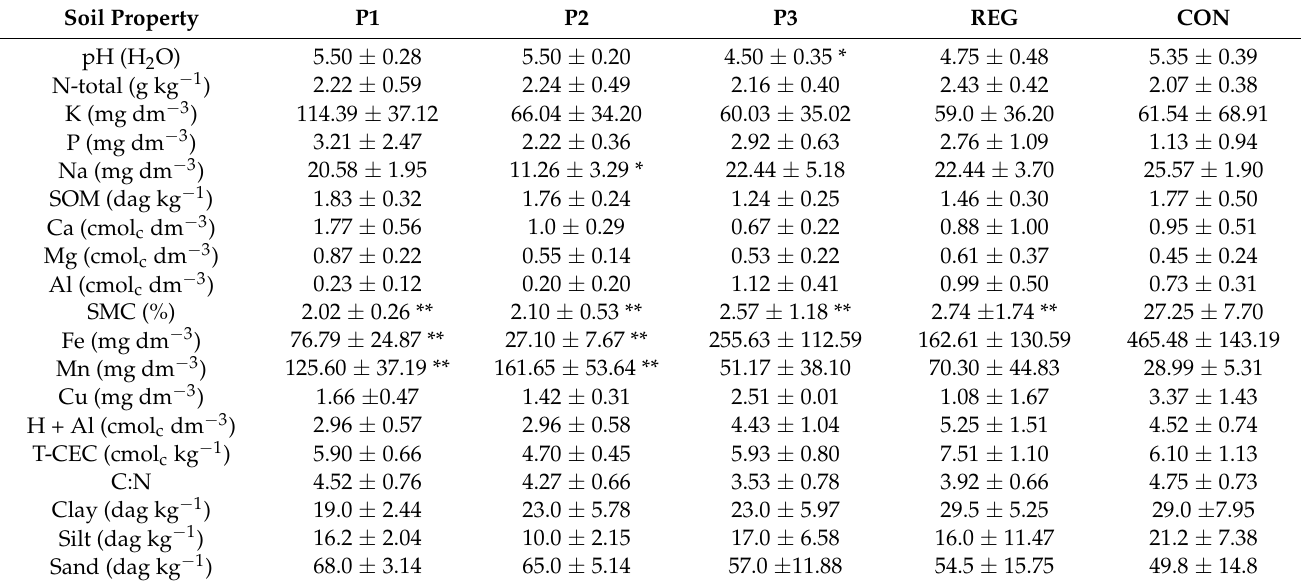
Table 2. Mean values and ± SD of soil properties (0–20 cm) of each restored area and degraded pasture (control), Fazenda Dourada,